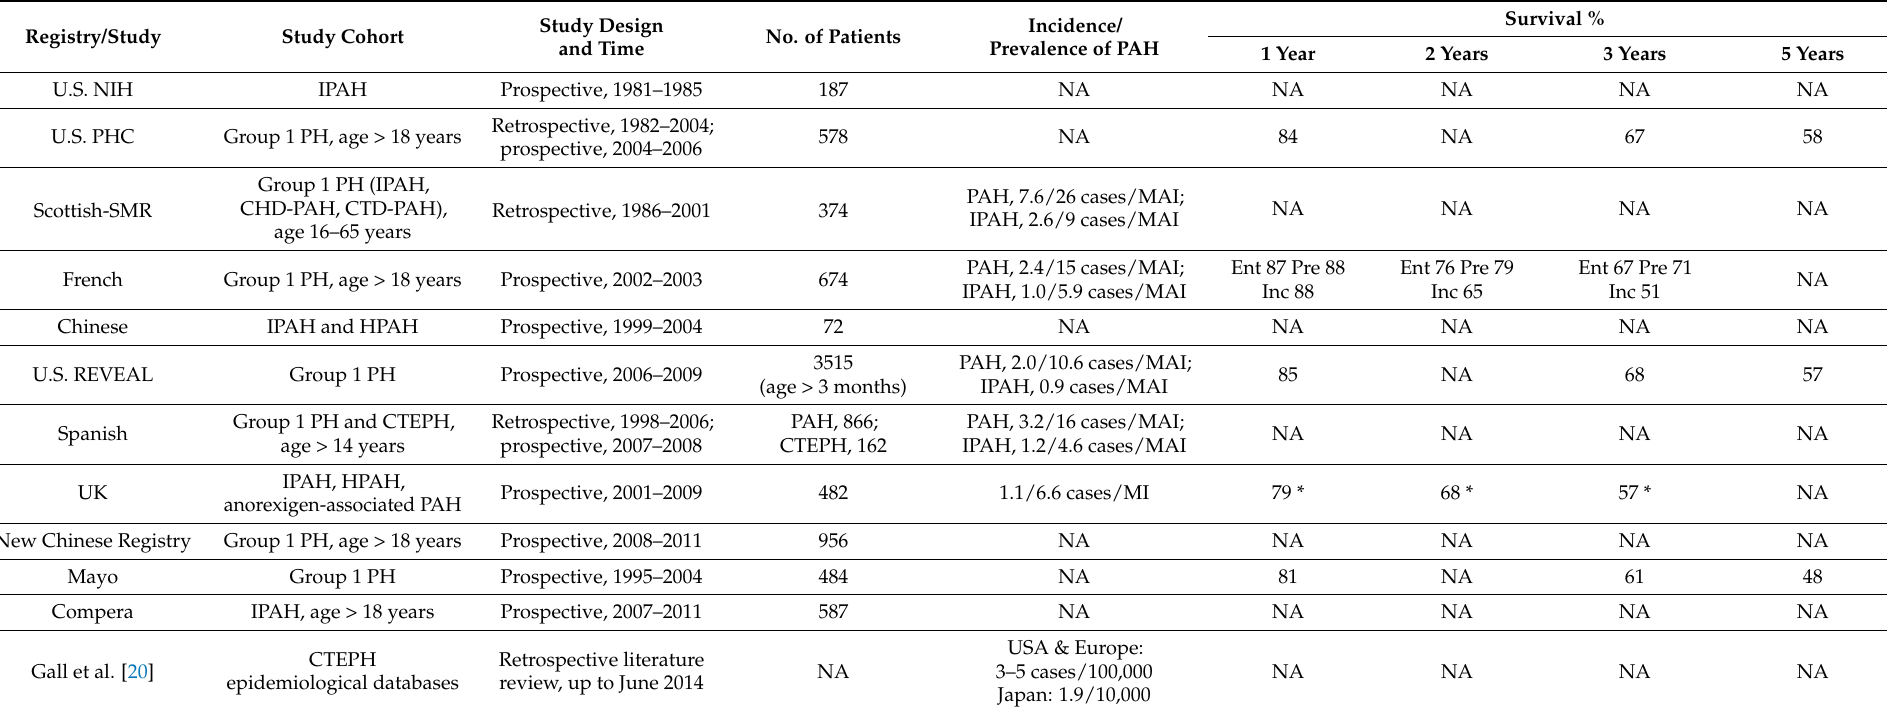
Table 1. Pulmonary arterial hypertension epidemiology registries (Adapted with permission from McGoon et al., 2013 [8]. Copyright 2013 American College of Cardiology Foundation, Elsevier Inc.) PH—Pulmonary hypertension; CHD—Congenital heart disease; CTD—Connective tissue disease; CTEPH—Chronic thromboembolic pulmonary hypertension; HPAH—Heritable pulmonary arterial hypertension; IPAH—Idiopathic pulmonary arterial hypertension; MAI—Million adult inhabitants; MI—Million inhabitants; NA—Not available; NIH—National Institutes of Health; PAH—Pulmonary arterial hypertension; PHC—Pulmonary hypertension connection; SMR—Scottish morbidity record; Ent—Entire study population; Inc—incident or newly diagnosed patients; Pre—Prevalent or previously diagnosed patients; CTEPH—chronic thromboembolic pulmonary hypertension; PTE—Pulmonary thromboembolism; PE—Pulmonary embolism. * Survival calculation only from IPAH and CTD-PAH